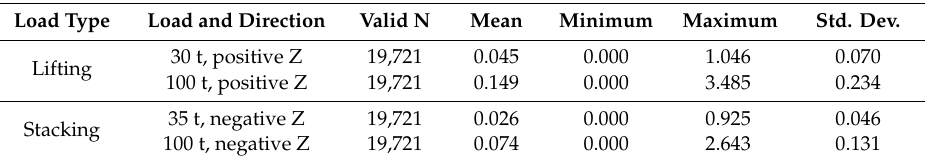
Table 9. Descriptive statistics of the inverse reserve factor (IRF).